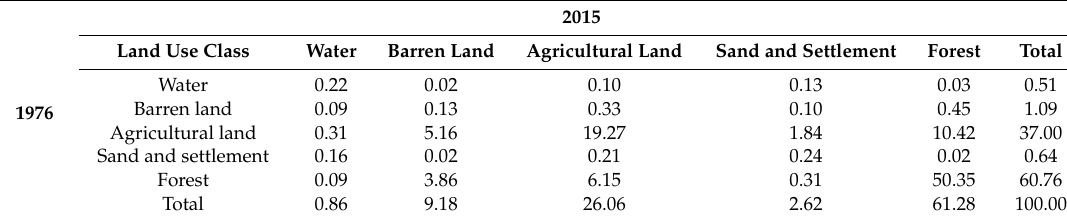
Table 5. Land use land cover change dynamics from 1976–2015 (in